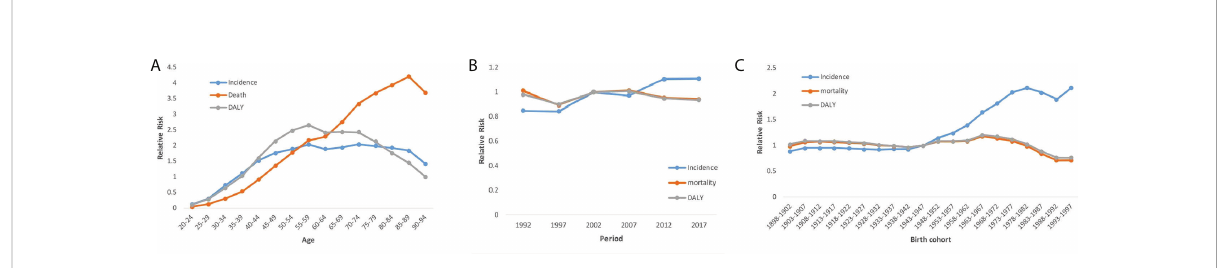
FIGURE 2 Cervical cancer incidence, disability-adjusted life-years (DALYs), mortality relative risks due to (A) age; (B) period; and (C) cohort